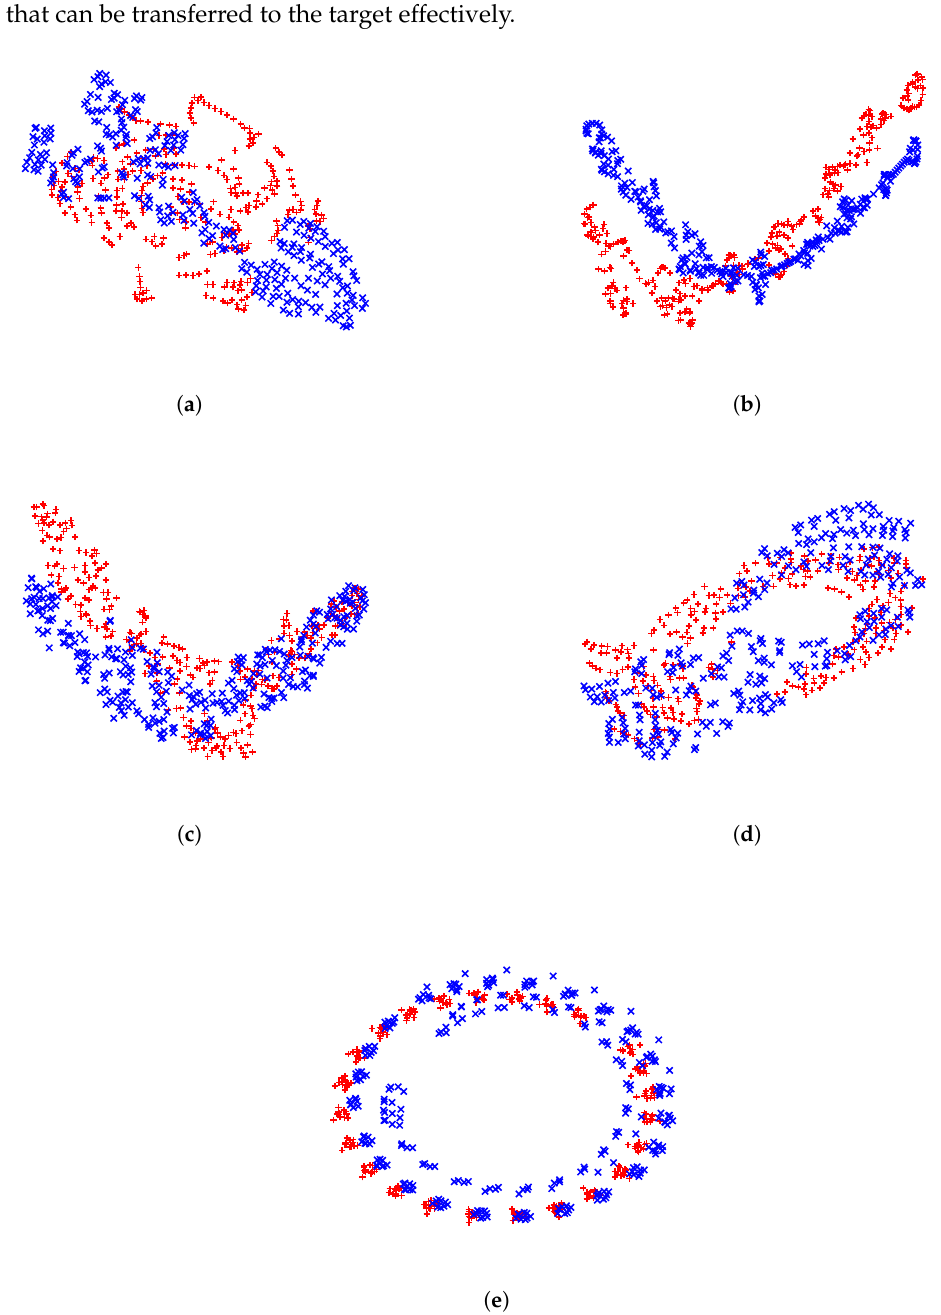
Figure 7. Feature visualization for different methods. Red points correspond to the source do- main, while blue ones correspond to the target domain. ( a ) WDGRL; ( b ) DAN; ( c ) DANN-LSTM; ( d ) DCORAL; ( e )